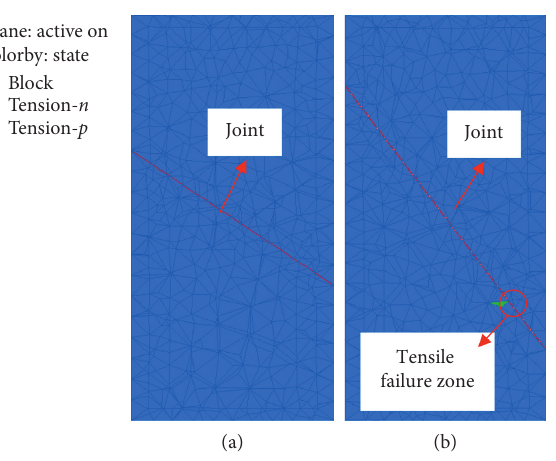
Figure 15: Tension failure area slice ( c � 30 ° and c � 50 °